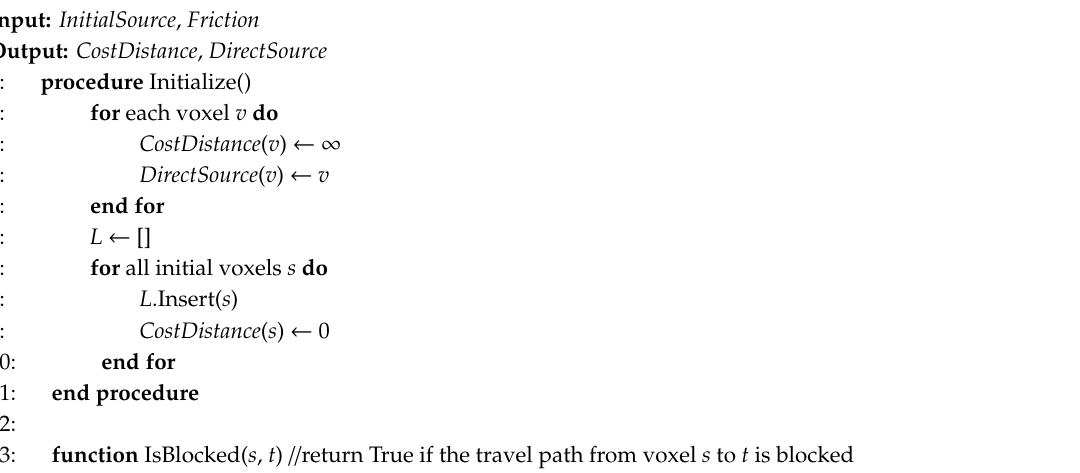
Algorithm 1 Pseudocode of Calculating 3D Cost